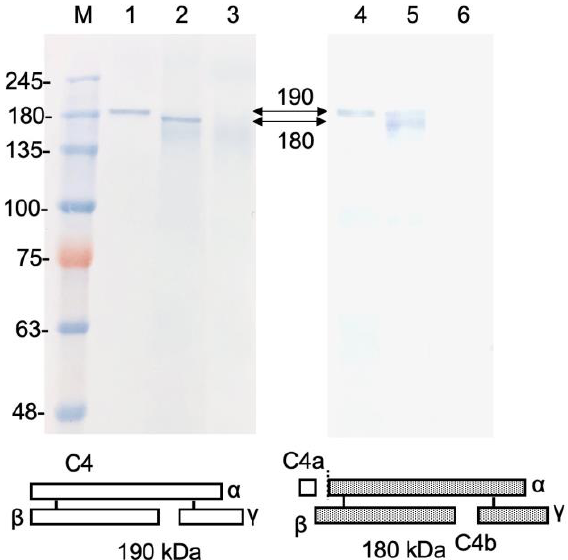
Figure 6. Proteolytic activation of carp C4-1 via C1r/s complex and MBL-MASP2 complex of carp detected via Western blotting with anti-C4-1 α-chain peptide antibody. Normal carp serum alone (lanes 1 and 4), normal carp serum incubated with C1r/s complex (lane 2), C1r/s complex alone (lane 3), normal carp serum incubated with MBL-MASP2 complex (lane 5), and MBL-MASP2 complex alone (lane 6) were run on 7.5% SDS-gel under non-reducing conditions. Molecular masses (kDa) of the marker proteins are shown on the left, and the observed molecular masses of intact C4-1 and its activated form (C4-1b fragment) are inserted in the middle. Models of polypeptide structures of intact C4 and C4b fragment are shown below the blots.